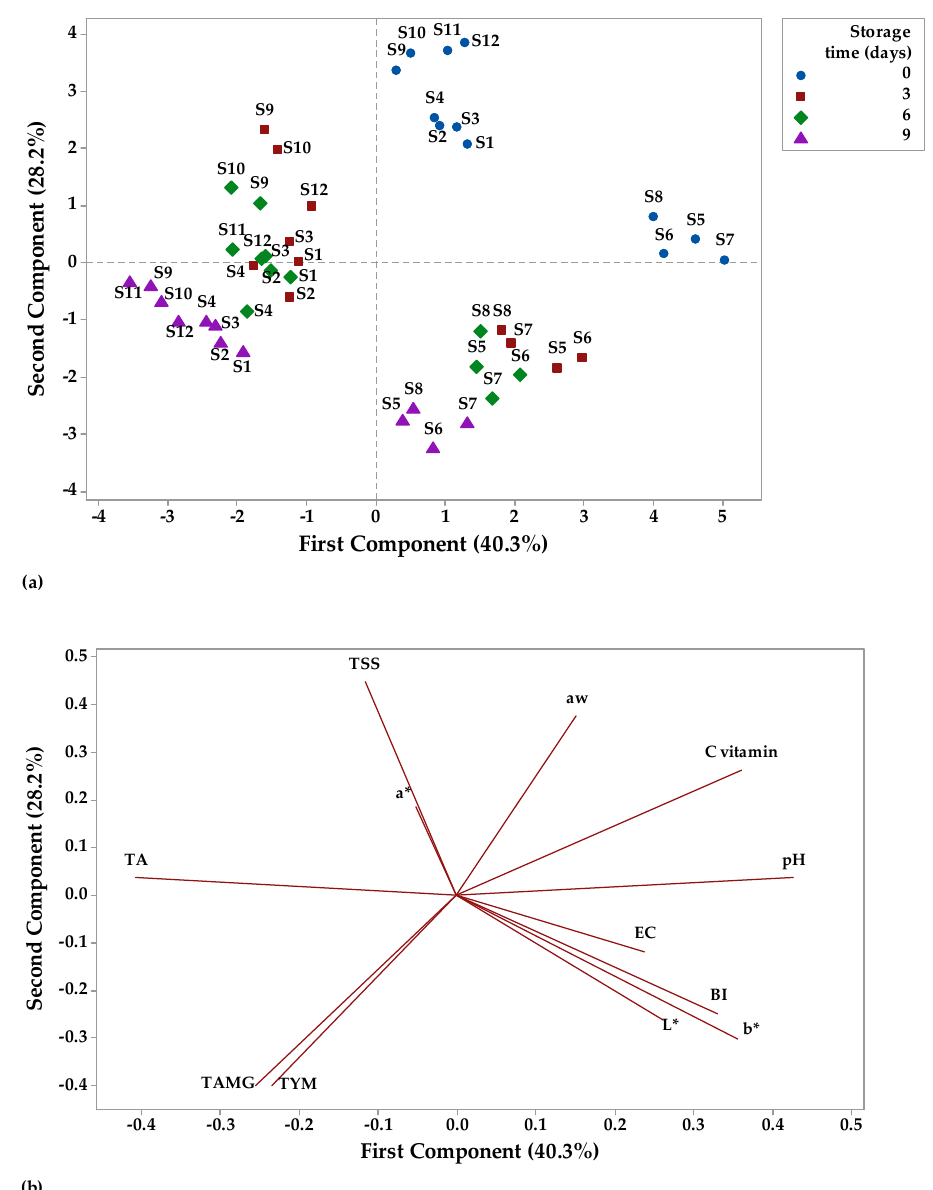
Figure 13. Principal component analysis (PCA) ( a ) scores and ( b ) loading plots of fruit juice samples stored at refrigerator temperature.